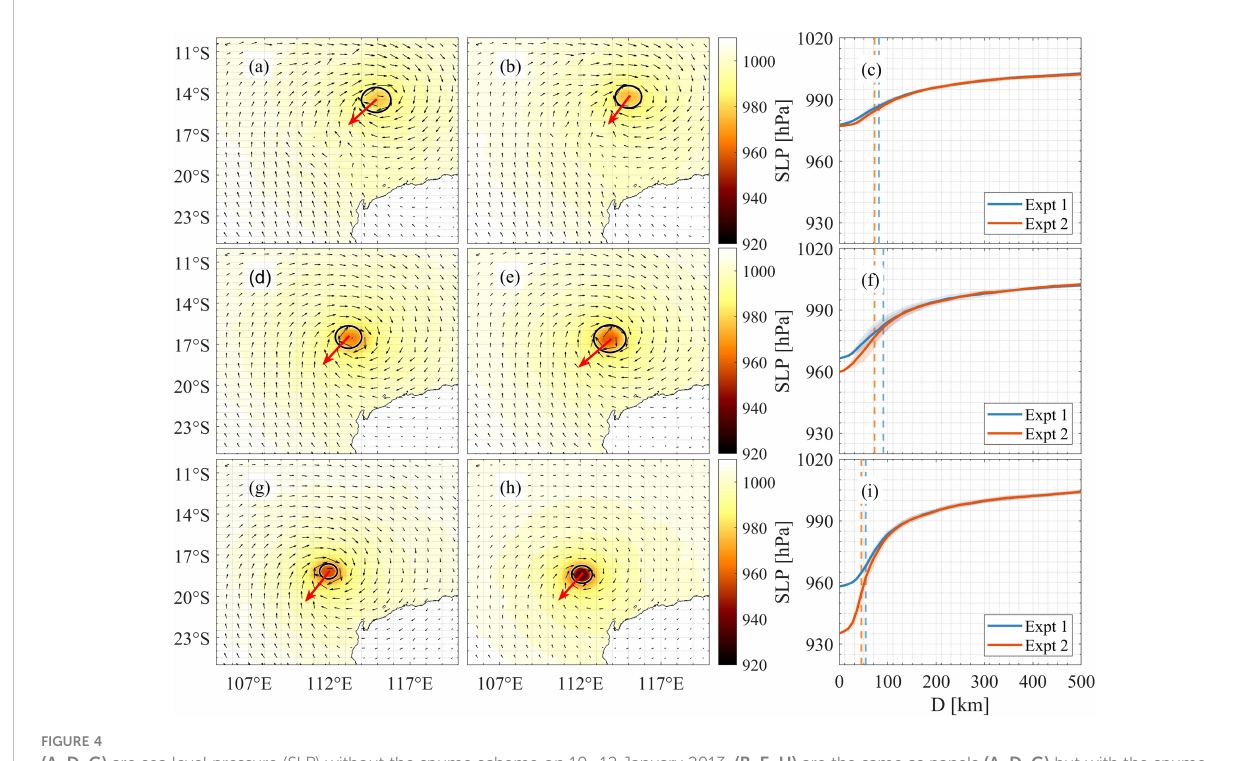
FIGURE 4 (A, D, G) are sea level pressure (SLP) without the spume scheme on 10 – 12 January 2013. (B , E , H) are the same as panels (A, D, G) but with the spume scheme. (C, F, I) represent the azimuthal averages of the SLP. The direction in which TC Narelle is moving forward at different times is demonstrated by the red arrows. The vectors are the directions of the local winds. The azimuthal averages of the SLP are shown by solid lines. The standard deviations of the SLP in all radial directions are represented by shadows. The radius of maximum wind is represented by solid circles and dashed lines in spatial distributions and azimuthal averages,